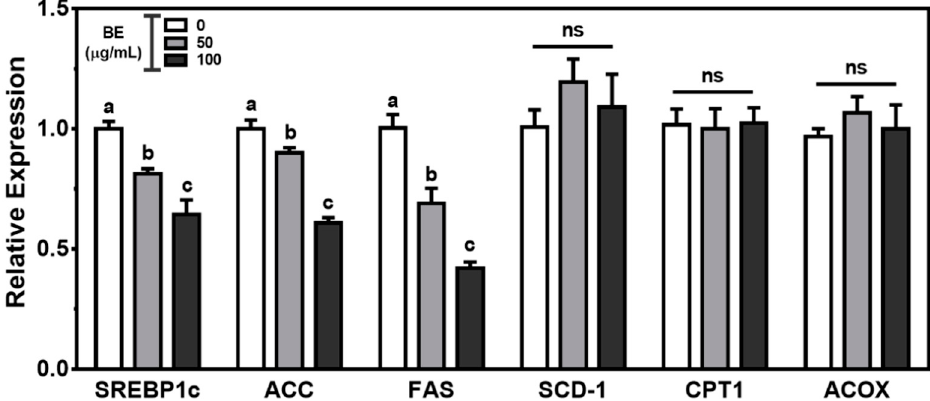
Figure 5. The genes involved in the fatty acid metabolism in BE-treated Caco-2 cells. The cells were treated with 50 or 100 µ g/mL of BE for 24 h. The mRNA expression was measured by qRT-PCR analysis. Data are expressed as relative expressions to control. Bars with different letters are significantly different ( p < 0.05), and ns indicates non-significance ( p > 0.05). Values are means ± S.E.M. n = 6.